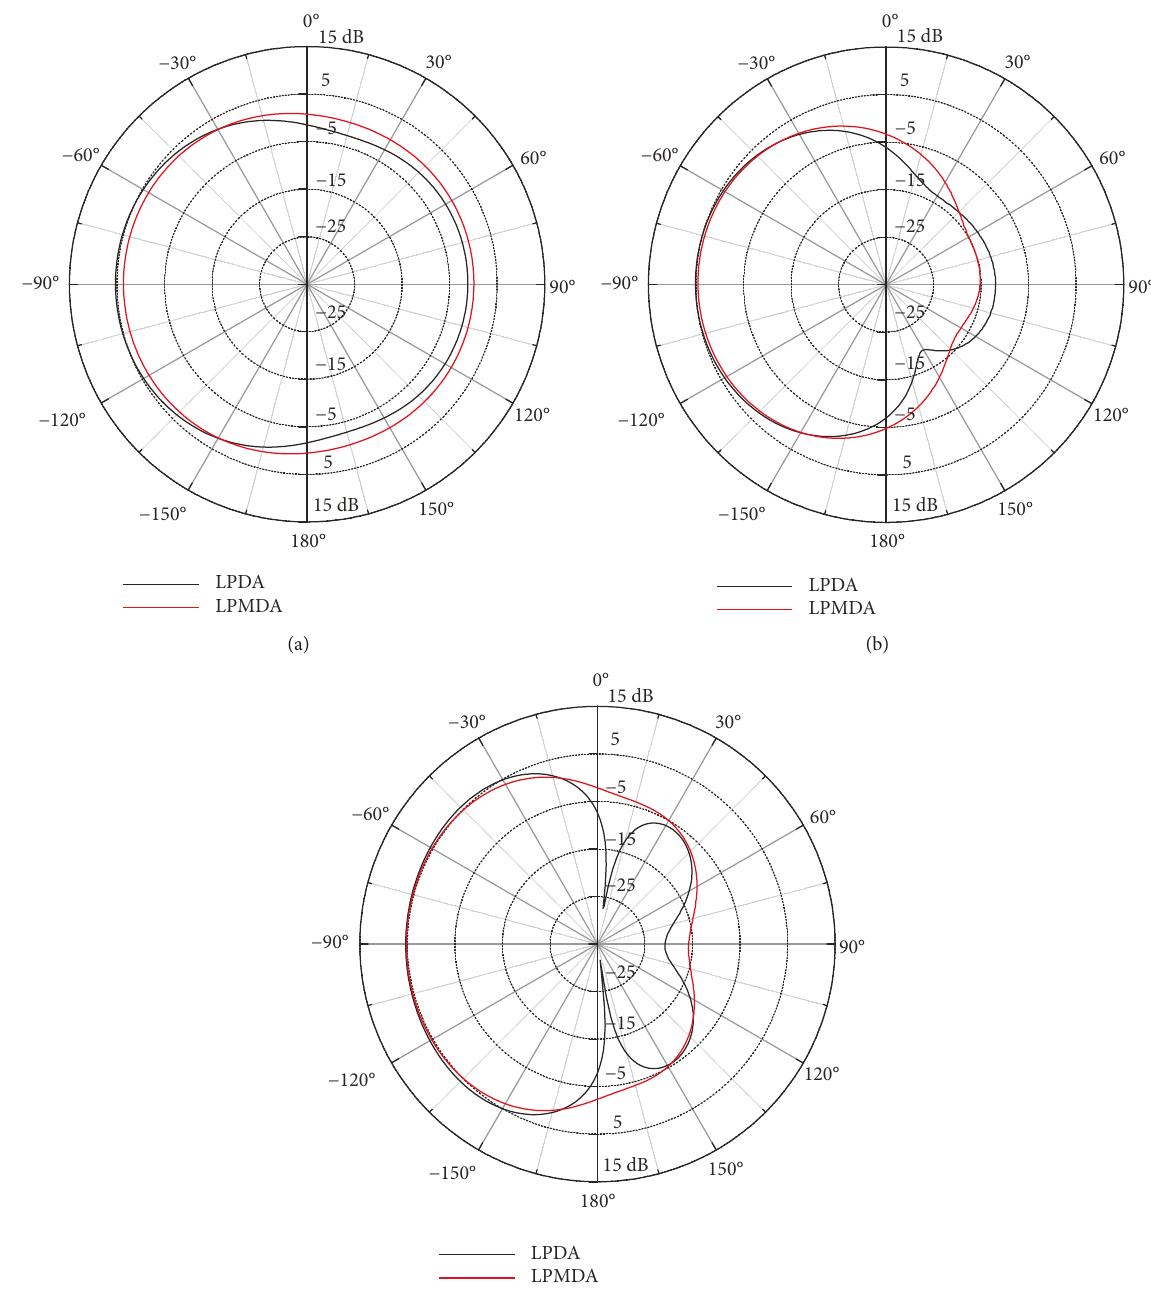
Figure 4: Simulated radiation patterns of the LPDA antenna and LPMDA antenna on the yz -plane at (a) 1GHz, (b) 1.3GHz, and (c)